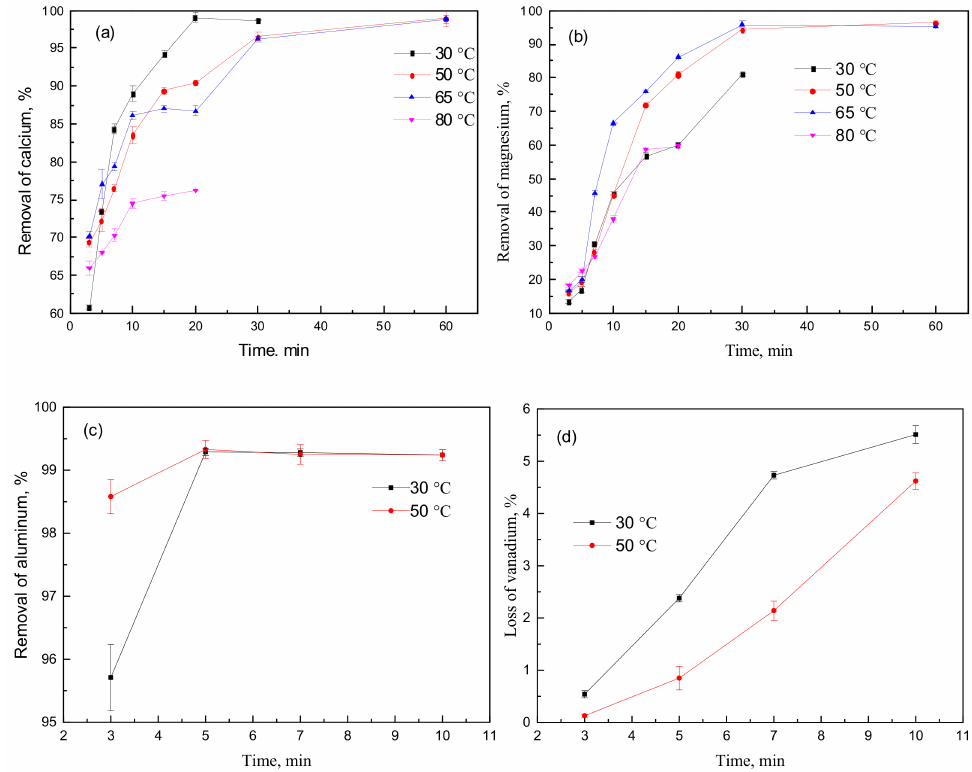
Figure 9. Effect of temperature and time on the removal of calcium ( a ), removal of magnesium ( b ), removal of aluminum ( c ) and loss of vanadium ( d